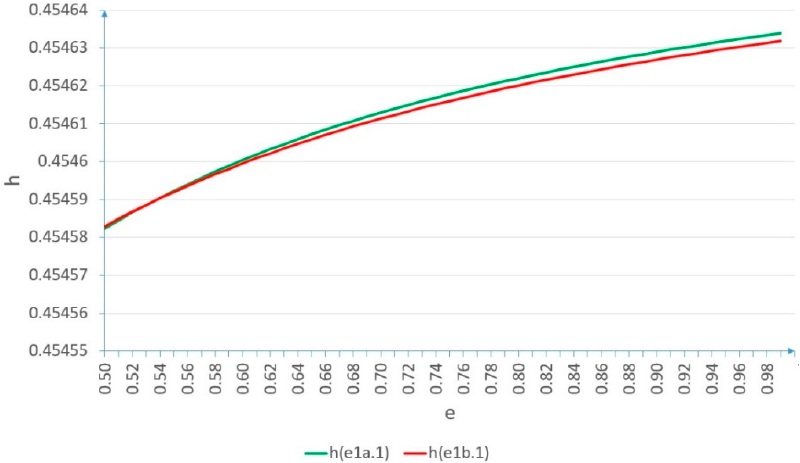
Figure 13. The result of the simulation of the h hypothesis value depending on the observation coefficients e1a.1 and e1b.1.